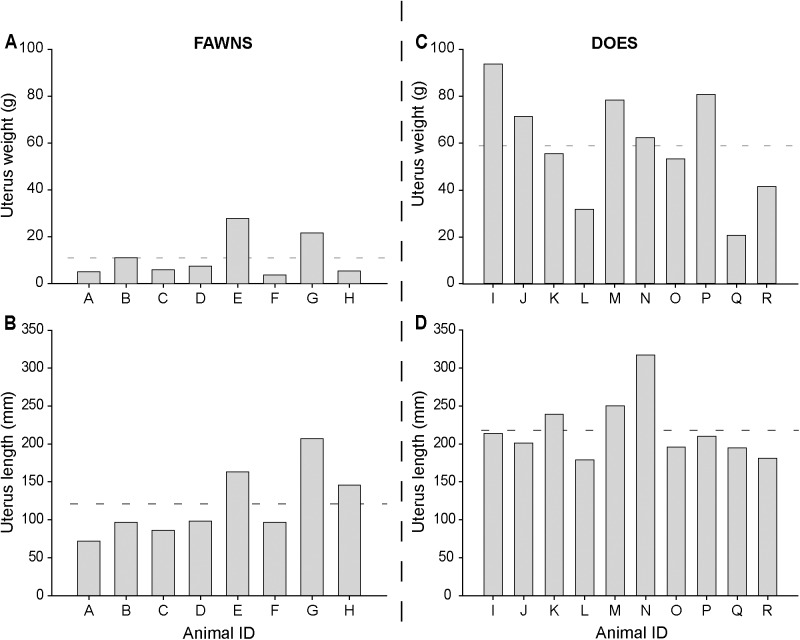
Uterus weight (A and C) and length (B and D) in white-tailed deer fawns (A and B; n = 8) and does (C and D; n = 10). Horizontal dashed line represents the overall mean within each figure.